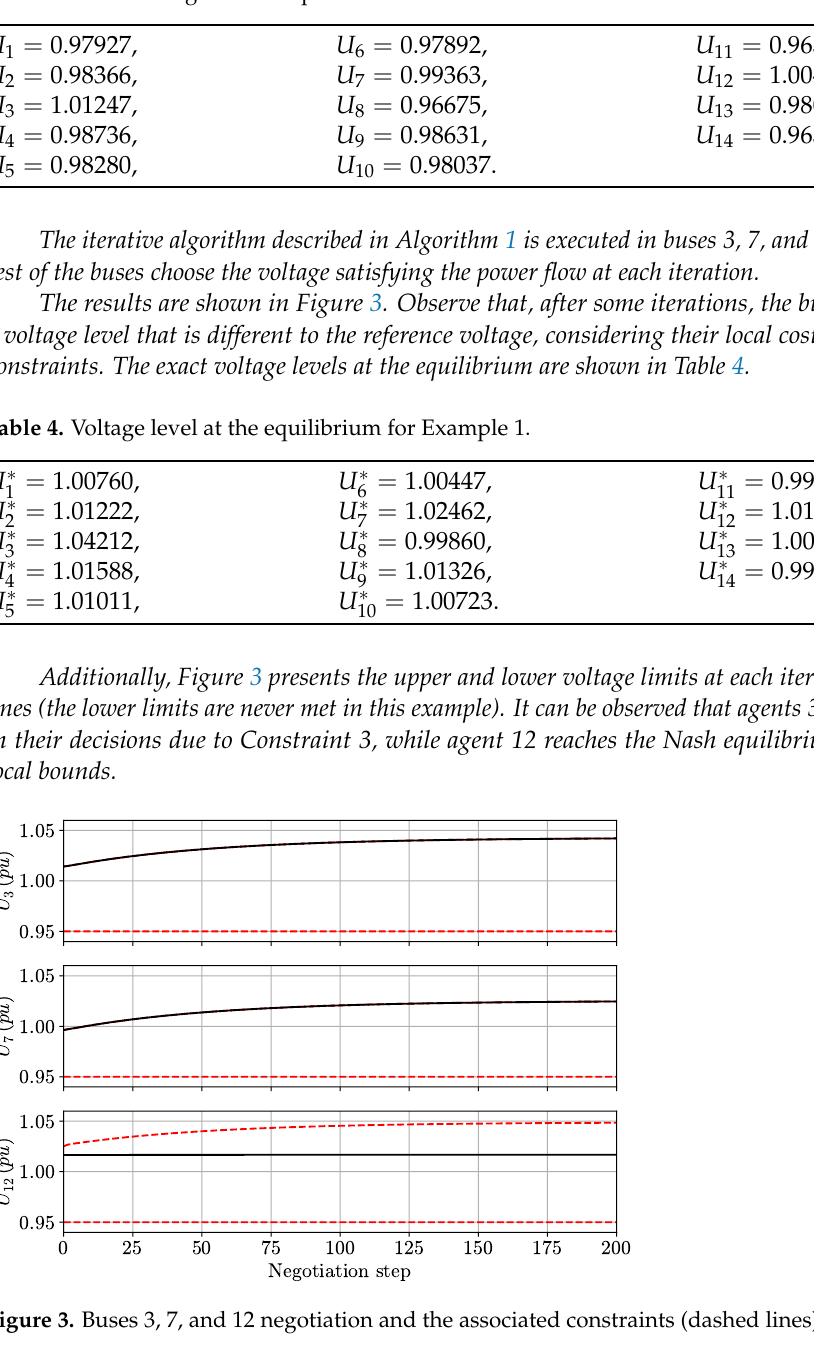
Table 3. Initial voltage levels in per unit.